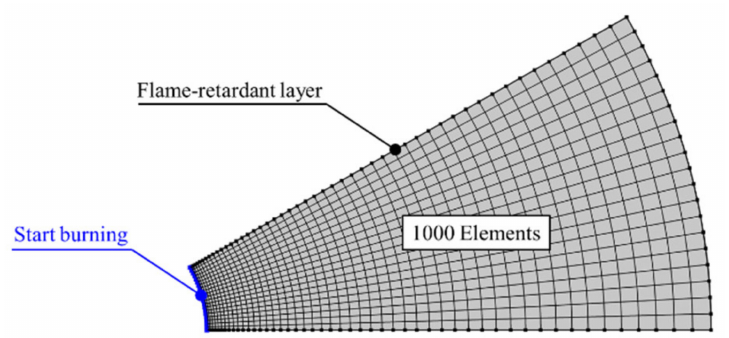
Figure 17. Mesh of the computational domain.